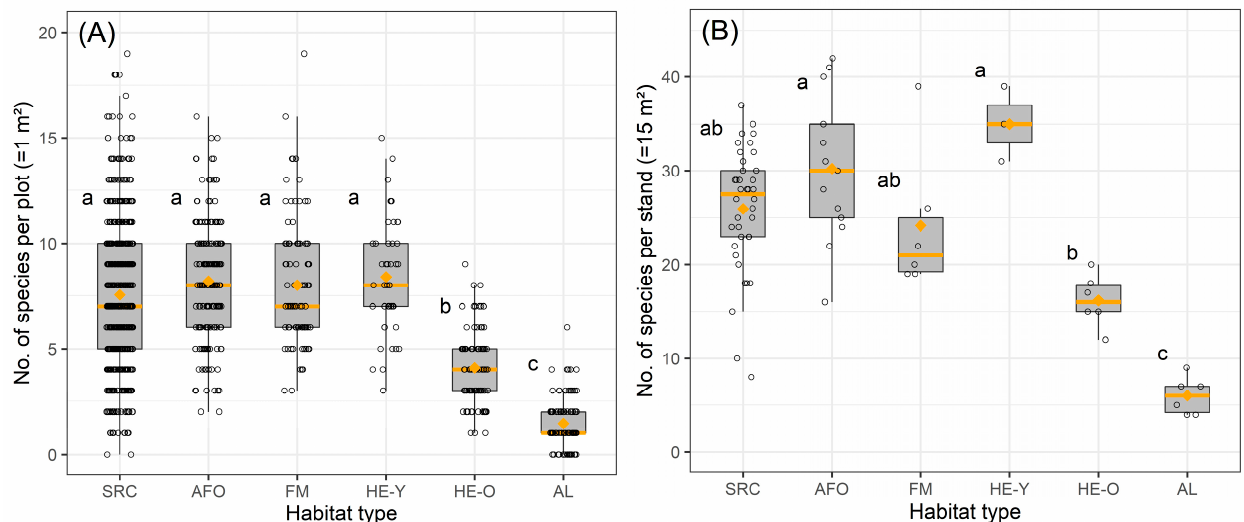
Figure 2. Species numbers of the different habitat types at plot-level ( A ) and at stand-level ( B ). Types with no consistent letter indicate significant differences ( p < 0.05). Median values are presented as horizontal orange lines, mean values as orange diamonds. Unfilled circles show the data of the single plots or stands sampled per type. In each boxplot, the boundaries of the box are the 25th and 75th percentiles and the whiskers represent the lowest and largest values no further than 1.5 times away from the 25th and 75th percentiles.